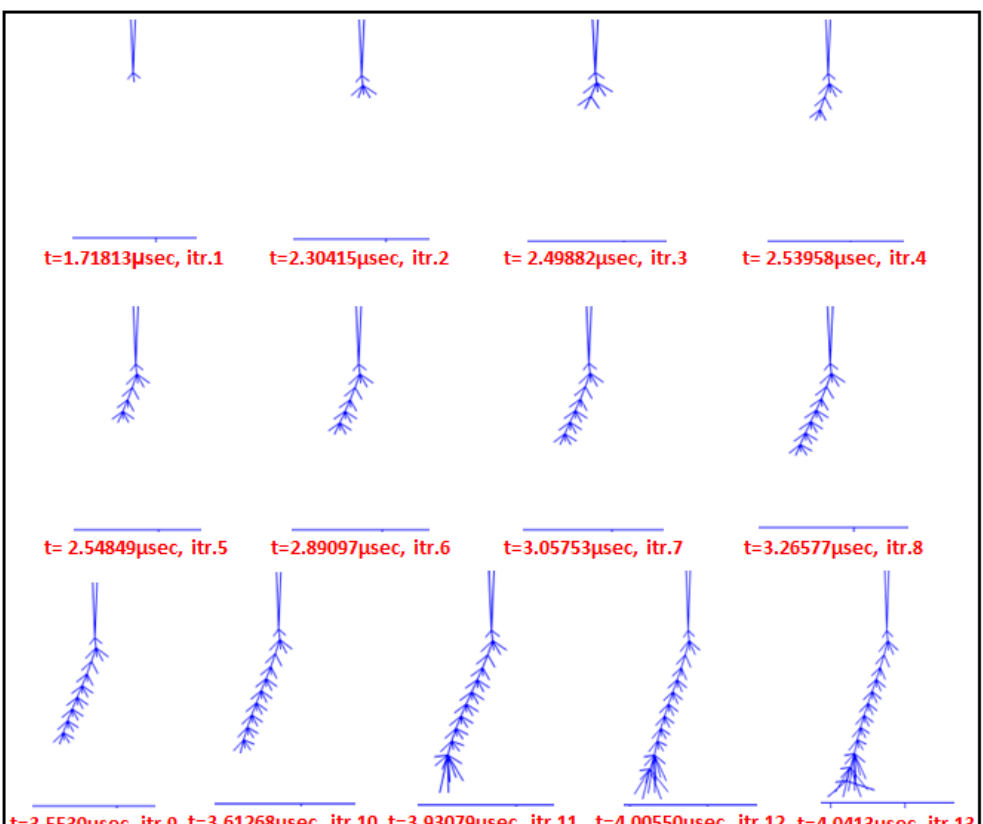
Fig. 3: The streamer development with the time within pin - plane arrangement in applied voltage of V = 13